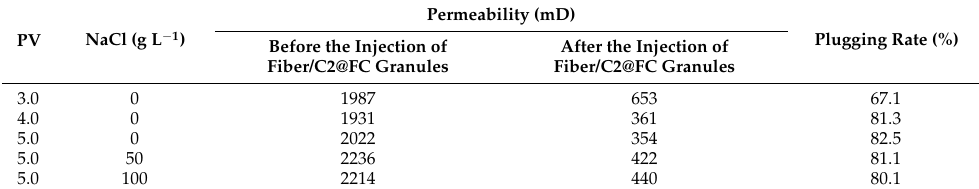
Table 2. Plugging rate of fiber/C2@FC granules with different injection volumes.